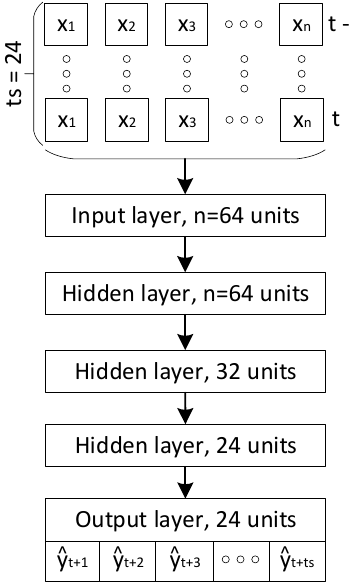
Figure 10. Architecture of the 4-layer ANN